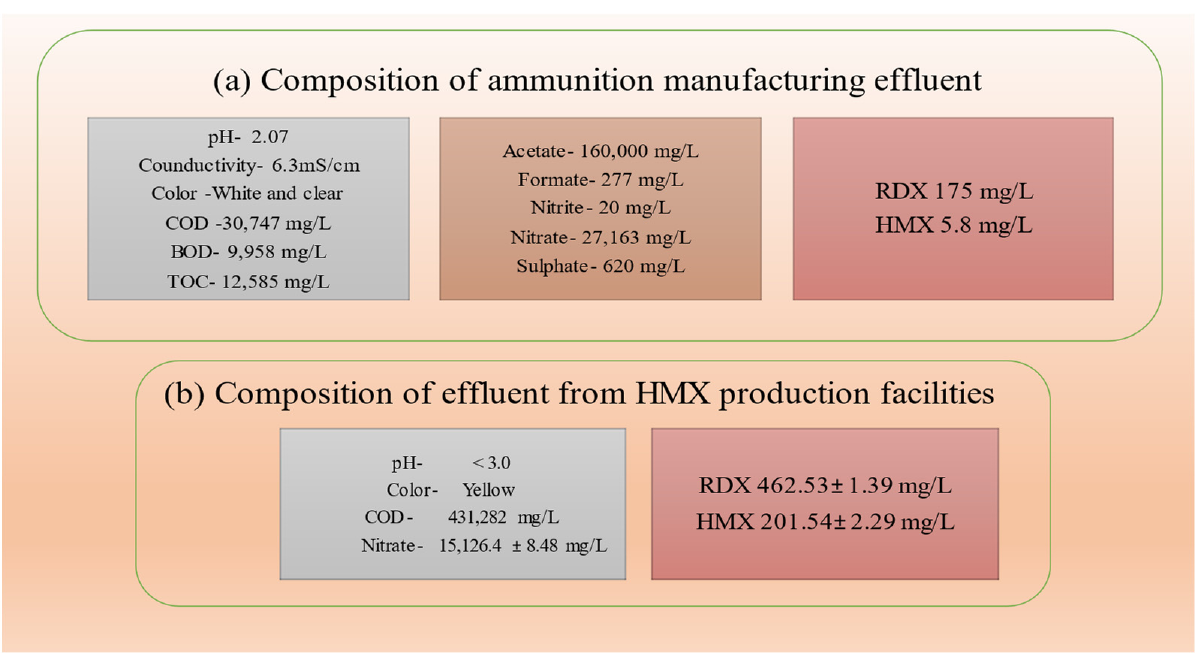
Figure 2. Characteristics of ( a ) ammunition manufacturing effluent [25] and ( b ) effluent of HMX production facilities [6].